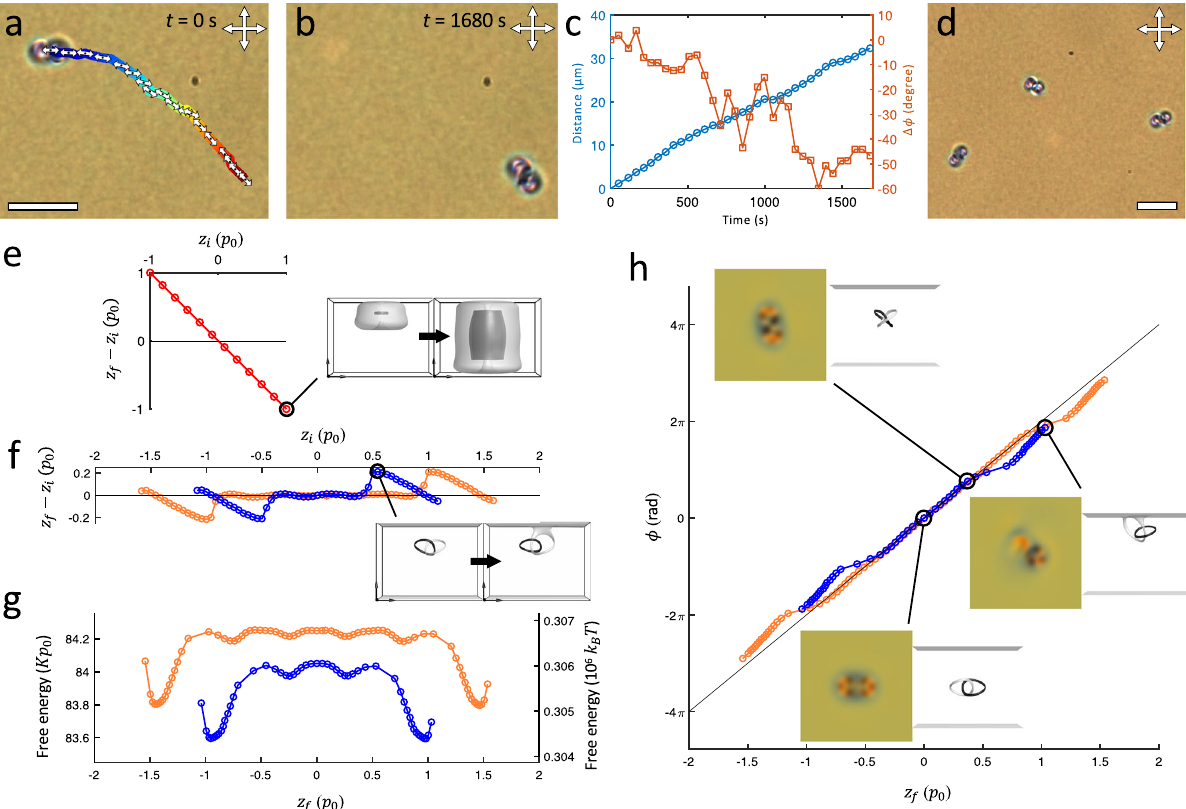
Fig. 6 3D Hopping of Hopf solitons. a – b Translational and orientational displacement of a Hopf soliton by repeated voltage switching shown at its initial ( a ) and fi nal ( b ) position. The 2D trajectory is color-coded by time and the long-axis orientations of the Hopf soliton in helical background at intermediate positions are shown by double arrows (plotted for every two switching cycles). c Distance and accumulated change in orientation in each transformation cycle ( Δ ϕ ) of a hopping Hopf soliton shown in a – b . d Hopf solitons in different long-axis orientations in a helical background with perpendicular con fi nement. e Displacement in z as a function of initial position z i of a hop fi on in the uniform background. f Displacement in z as a function of initial position z i of a heliknoton in the helical background. g – h Free energy ( g ) and orientation ( h ) dependence of a heliknoton on equilibrium position z f . In f – h , heliknotons with d ¼ 3 p 0 and d ¼ 4 p 0 are shown in blue and orange, respectively. The insets in e , f show the initial and fi nal equilibrated Hopf solitons of the corresponding data points by polar preimages. Insets in h show the simulated POM images (viewed along ^ z ) and the preimages (viewed along ^ y ) of the solitons with z positions 0, 0.42 p 0 , and 1 p 0 relative to the midplane (left to right) for d ¼ 3 p 0 . The line in h shows ϕ ¼ 2 π ð z f = p 0 Þ for bulk heliknotons is a guide to the eye. Free energy is in units of Kp 0 and k B T , where K ¼ 6 : 47 pN is the average elastic constant of 5CB and p 0 ¼ 2 : 33 µ m, k B is the Boltzmann constant, and temperature T ¼ 300 K. d ¼ 3 p 0 in experiments in a – d and scale bars are 10 µ